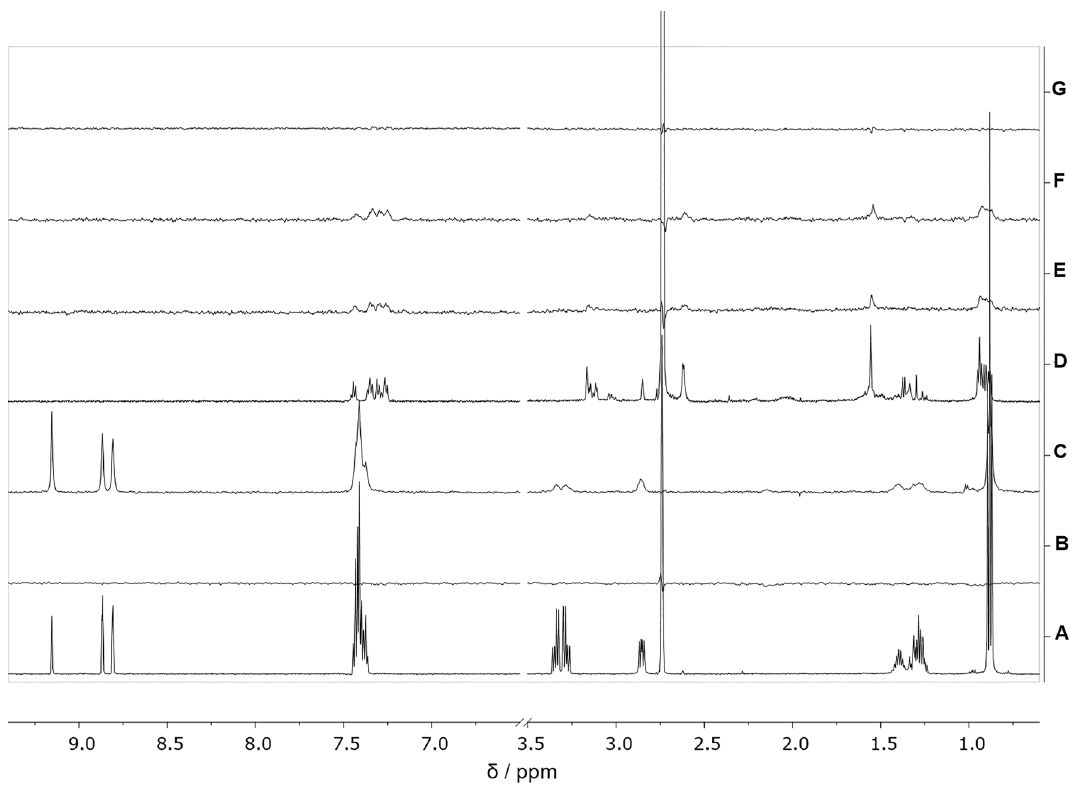
Figure 9. NMR spectra. ( A ) 1 H NMR spectrum of 500 μM BTZ dissolved in 20 mM PB, MgCl 2 , pH 7.4, d 6 -DMSO 8% v/v, 37 °C; ( B ) STD NMR spectrum of 500 μM BTZ dissolved in 20 mM PB, MgCl 2 , pH 7.4, d 6 -DMSO 8% v/v, 37 °C; ( C ) STD NMR spectrum of 500 μM BTZ and tubulin α/β dimers 10 μM in polymeric form dissolved in 20 mM PB, MgCl 2 , GTP 100 μM, pH 7.4, d 6 -DMSO 8% v/v, 37 °C; ( D ) 1 H NMR spectrum of 500 μM CFZ dissolved in 20 mM PB, MgCl2, pH 7.4, d 6 -DMSO 8% v/v, 37 °C; ( E ) STD NMR spectrum of 500 μM CFZ dissolved in 20 mM PB, MgCl 2 , pH 7.4, d 6 -DMSO 8% v/v, 37 °C; ( F ) STD NMR spectrum of 500 μM CFZ and tubulin α/β dimers 10 μM in polymeric form dissolved in 20 mM PB, MgCl 2 , GTP 100 μM, pH 7.4,